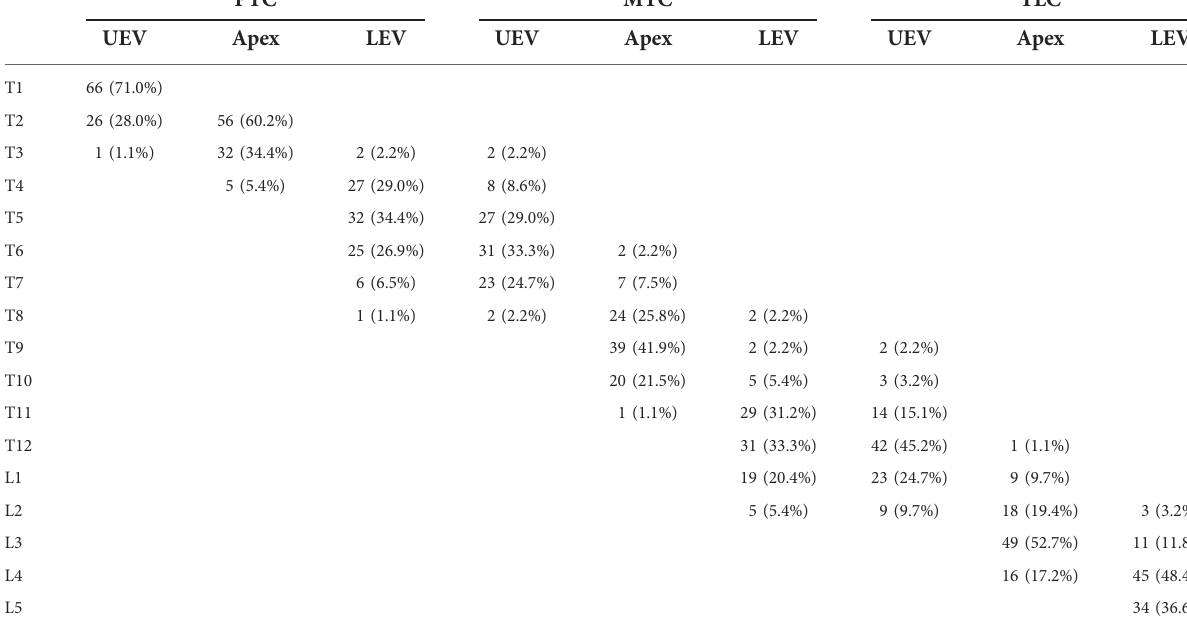
shown in Table 5 . There was a signi fi cant difference in VB-HU at the apex among the subgroups. Although the VB-HU within the concave side at the apex gradually decreased with increasing Cobb angle, there was no signi fi cant difference among the subgroups. However, the mean VB-HU and the VB-HU within the convex side at the apex signi fi cantly decreased from the mild to severe group ( Figure 5 ). No signi fi cant difference was detected in VB-HU at UEV and LEV between the mild and moderate groups, while VB-HU in the severe group was signi fi cantly less than that in the other groups. Between the mild and moderate groups, the VB-HU within neither side was signi fi cantly different